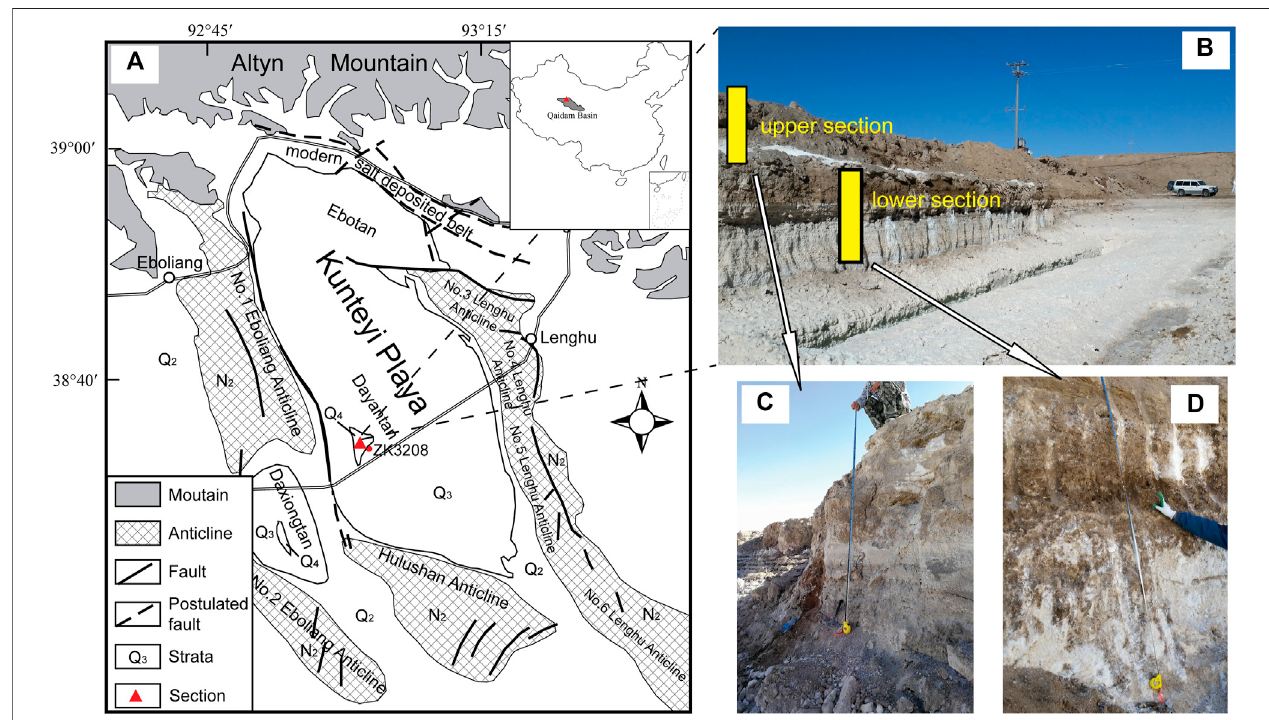
FIGURE1| SketchoftheKunteyiBasinandthesectionwithpolyhalitedepositsweselectedinthisstudy. (A) theKunteyiBasinanditssurroundinggeomorphology ((Altyn Mountain to the north, uplifted anticlines, mainly the Lenghu structure No. 3, No.4, No. 5, and No. 6) to the east and south, Hulushan anticline (No. 1 and No. 2), and Eboliang anticlines, respectively); (B) the selected geological section comprised of upper (C) and lower (D) section.